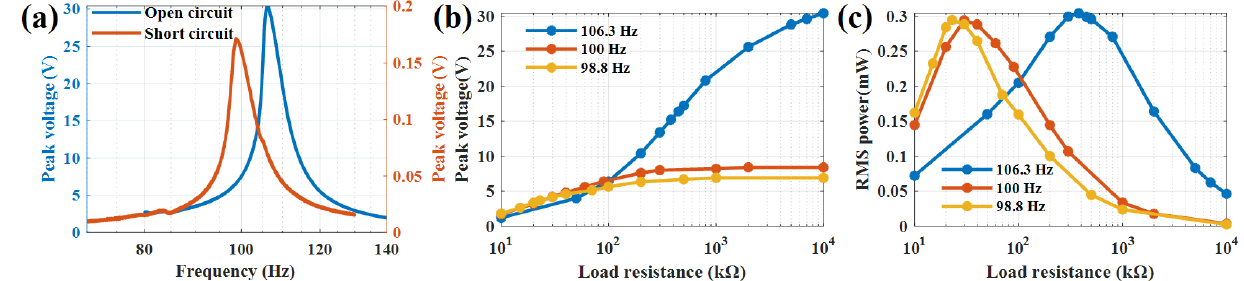
Figure 4. PVEH frequency modulation result by load impedance: ( a ) PVEH experimental peak voltage frequency response curves at open circuit (load resistance of 10 MΩ) and short circuit (load resistance of 1 kΩ); PVEH experimental ( b ) peak voltage and ( c ) RMS power in different load resistance at 106.3 Hz, 100 Hz and 98.8 Hz, respectively.